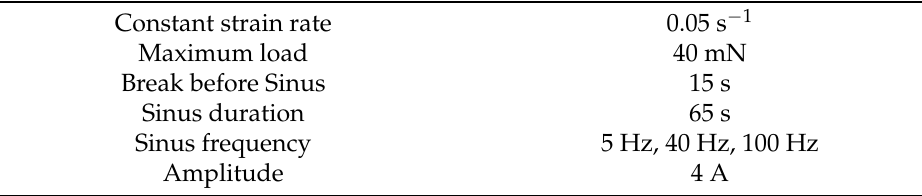
Figure 6. Dynamic load-displacement-time curves on the EVA surface obtained using a frequency sweep during the hold. Table 2. Indentation parameters for creep